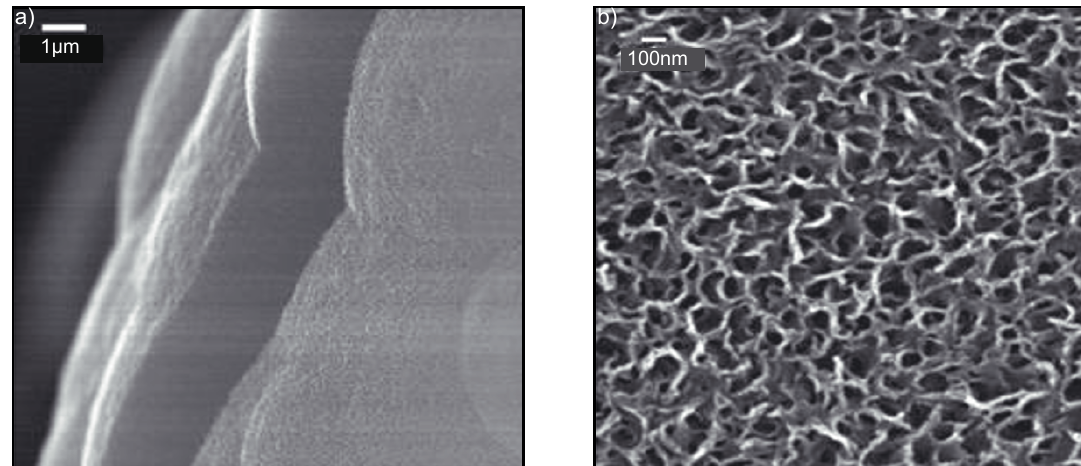
Figure 7. CHA after 21 days, 37°C in SBF, pH = 7.4: a) lateral surface of chip; b) top surface